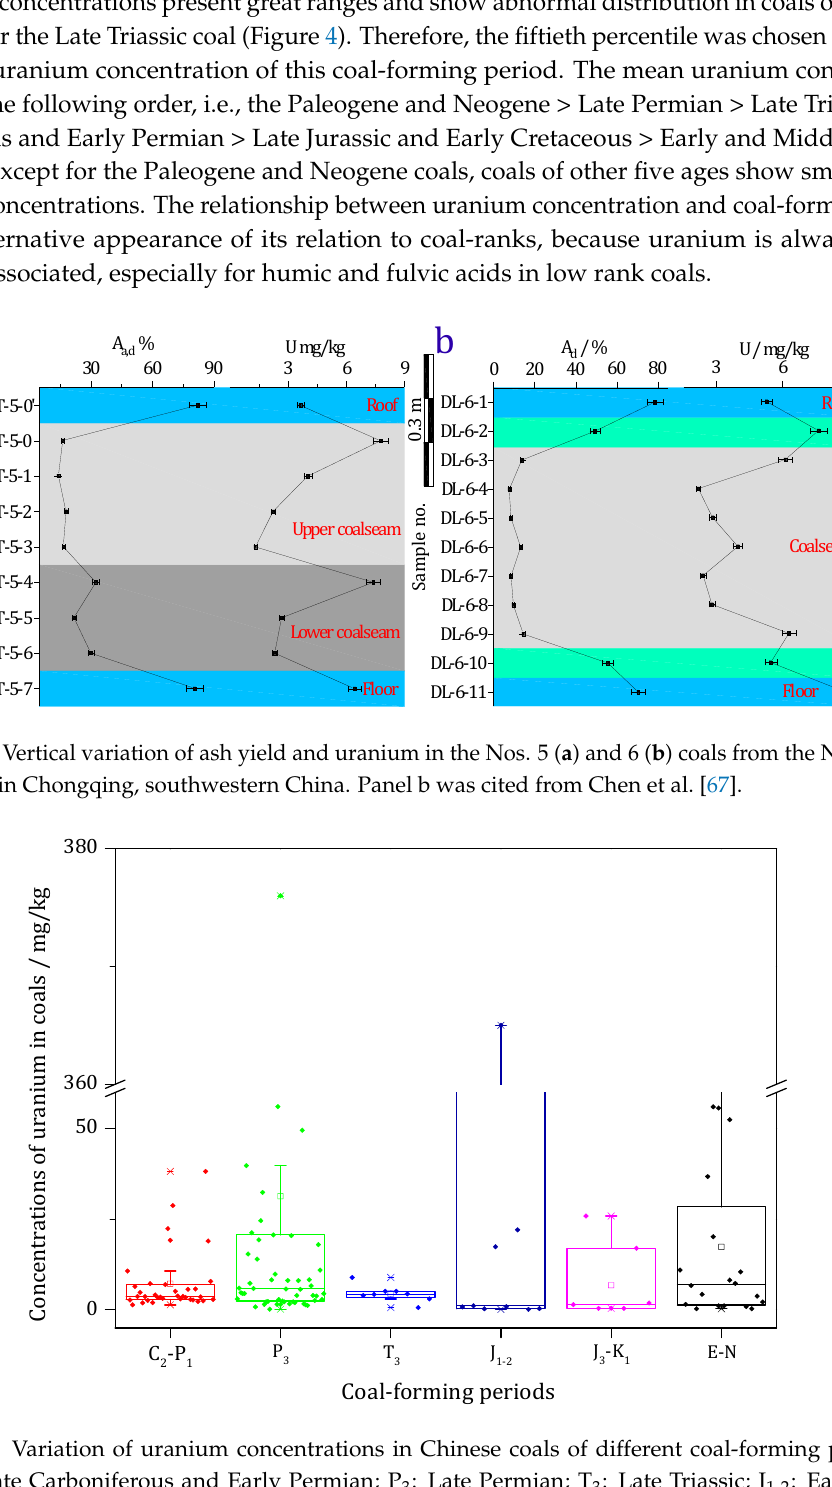
Figure 3. Vertical variation of ash yield and uranium in the Nos. 5 ( a ) and 6 ( b ) coals from the Nantong coalfield in Chongqing, southwestern China. Panel b was cited from Chen et al. [67].